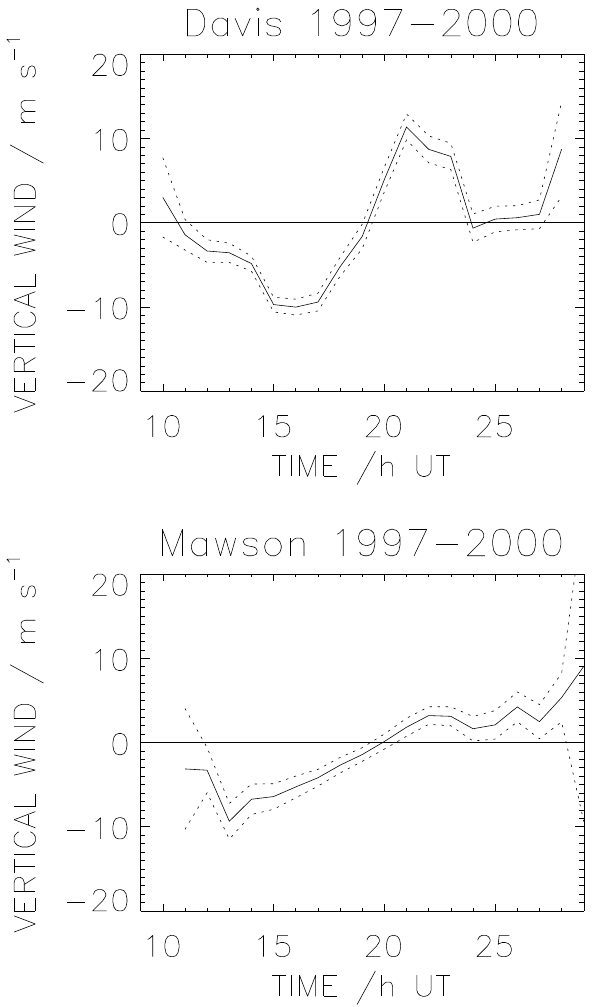
Fig. 3. Hourly mean vertical winds and intensity for the combined four-year data set, 1997–2000, for the two stations, Davis (top) and Mawson